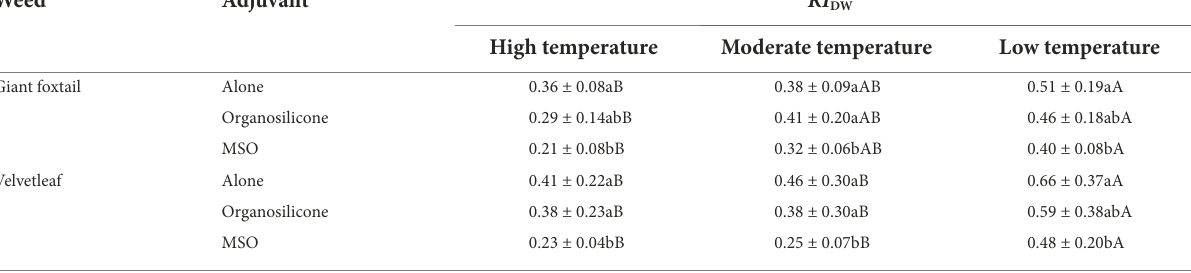
TABLE 4 Effects of two adjuvants on the dry weight of giant foxtail (Setaria faberi Herrm.) and velvetleaf (Abutilon theophrasti Medik.) at 3 weeks after application. Weed